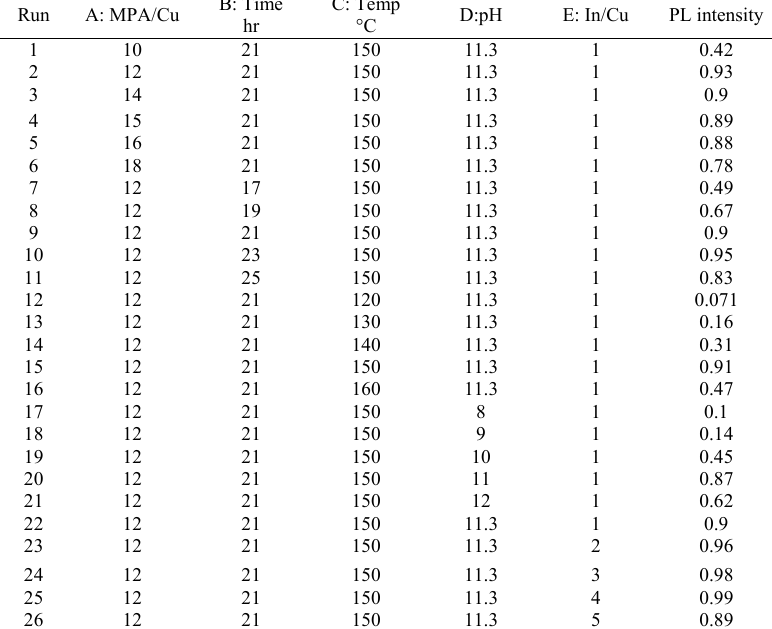
Table 2: The design table of experiments and response values Table 2. The design table of experiments and response